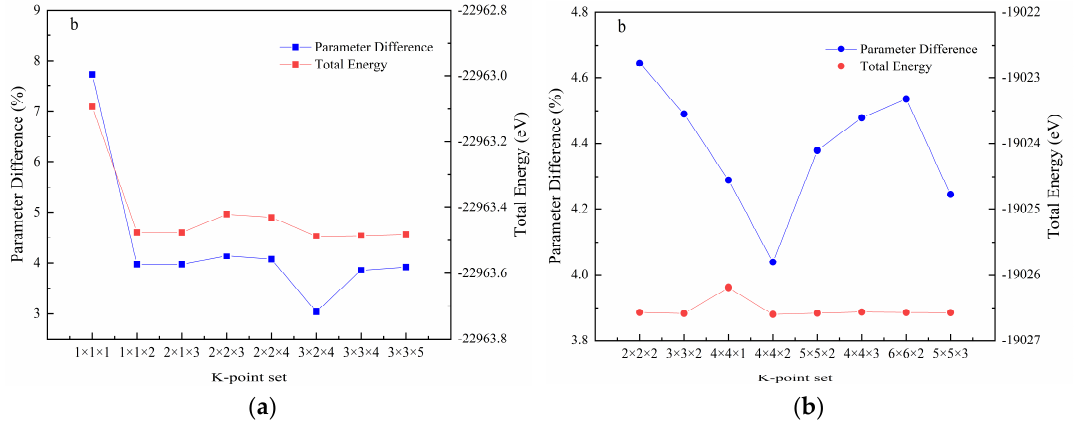
Figure 1. Total energy and lattice parameter difference as a function of the k-points set mesh with the kinetic cutoff energy of 300 eV for hemimorphite ( a ) and smithsonite ( b ).